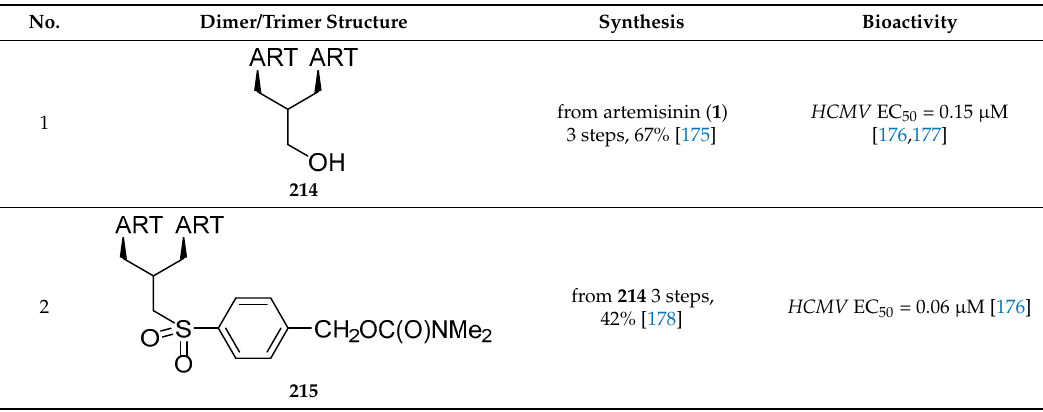
Table 1. Dimers and trimers of artemisinin showed antiviral activity.